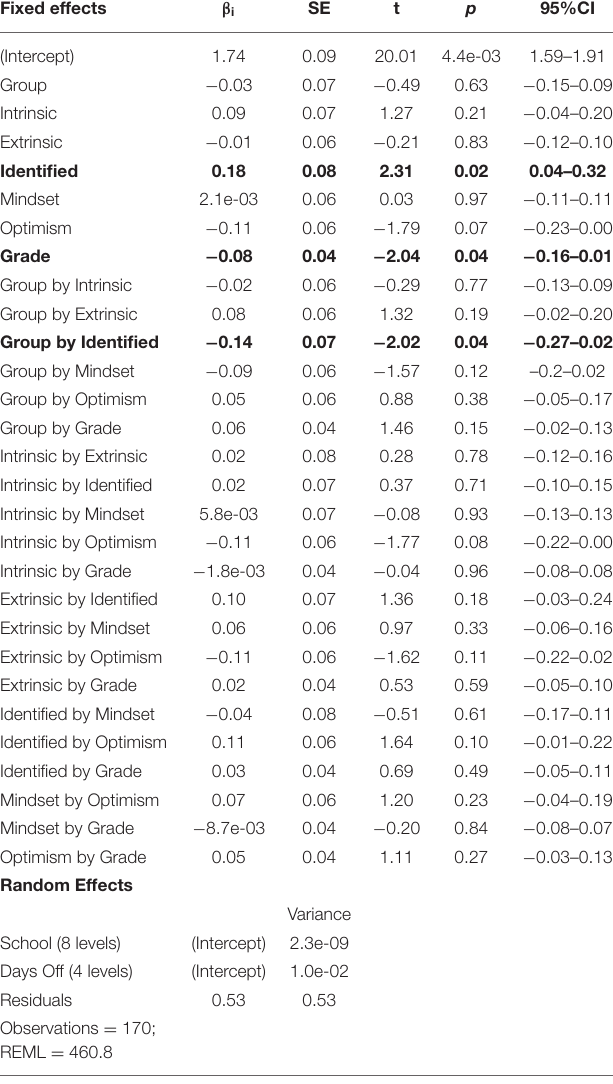
TABLE 2 | Linear mixed effects model of time spent on math homework in N = 170 middle school students tested during two periods of COVID-19 related lockdown with schools closed (group 1) and open (group